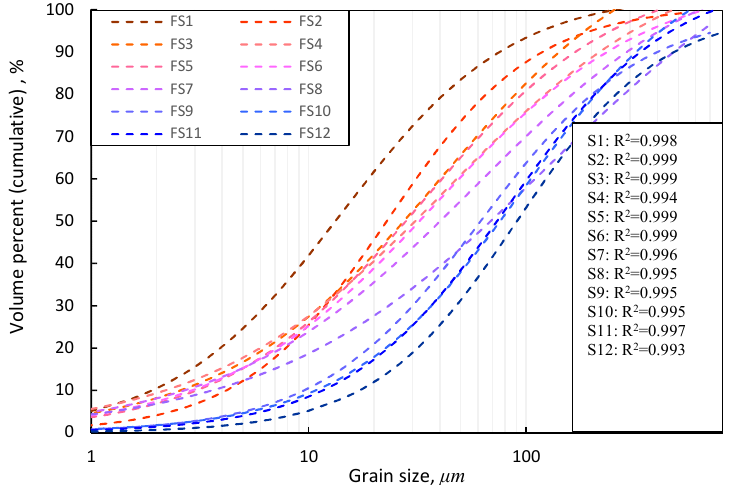
Figure 6. Model curve of tailings samples.